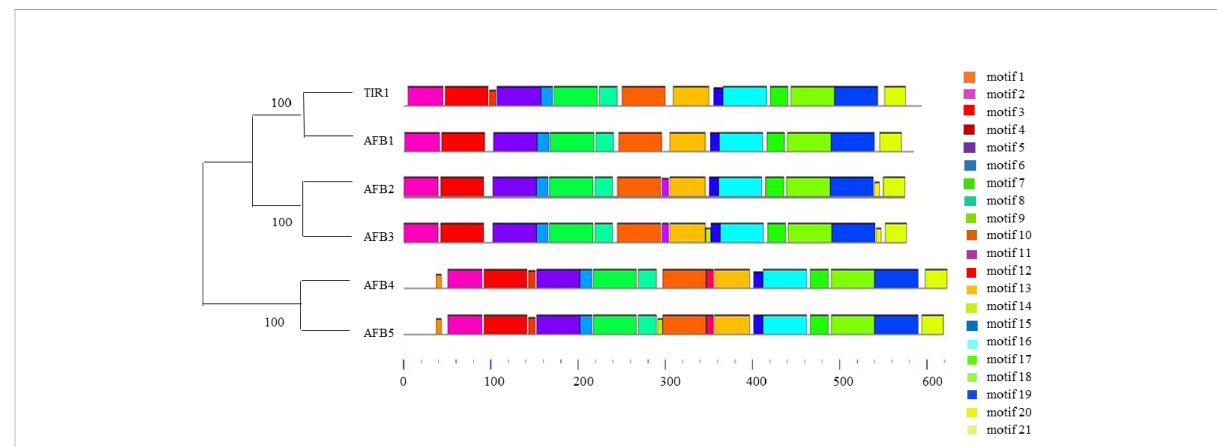
FIGURE 1 Neighbor-joining phylogenetic tree (left) and conserved motif (right) analysis of TIR1/AFBs in Arabidopsis